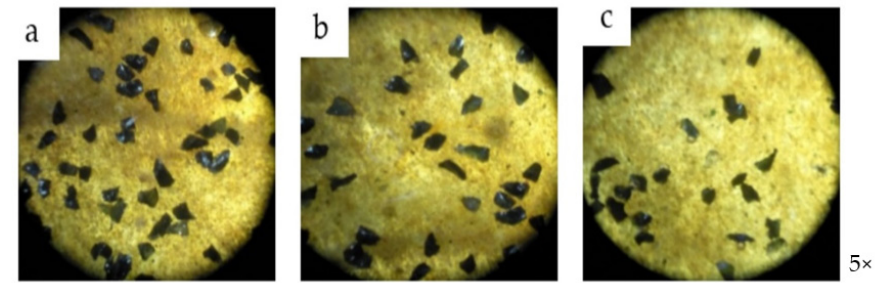
Figure 5. Microstructure photographs illustrating top surfaces of fabricated polymer composite samples. ( a ) At 18 wt.% of SiC; ( b ) At 12 wt.% of SiC and ( c ) At 6 wt.% of